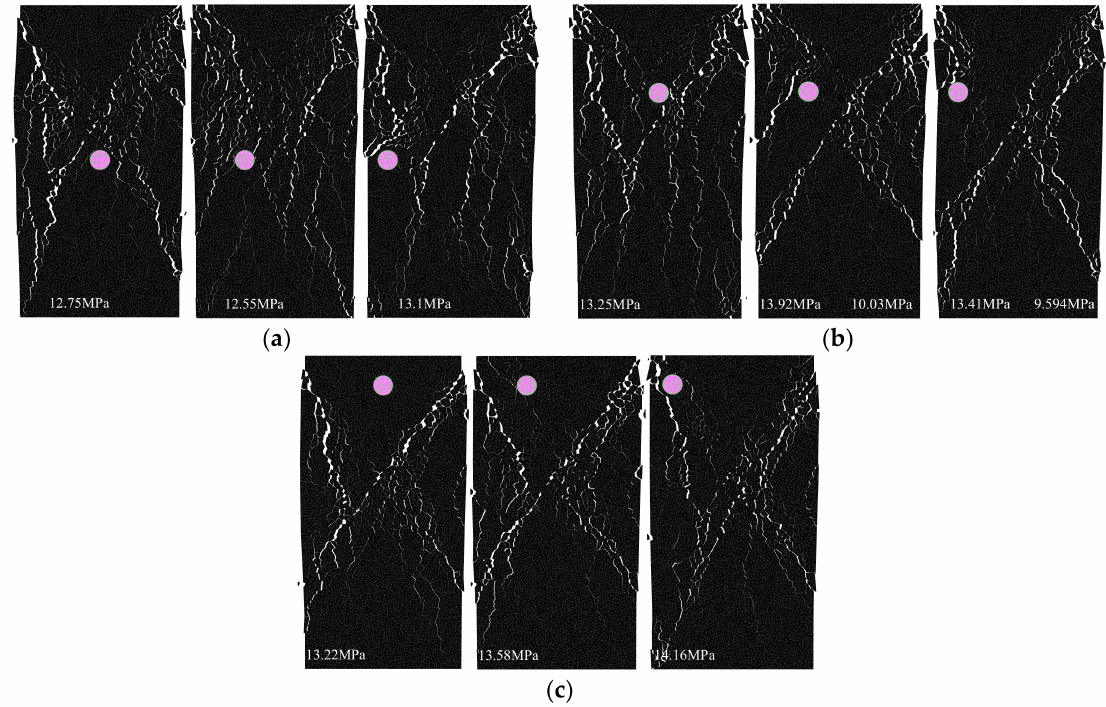
Figure 16. Crack pattern of rock specimen with one mineral circle in different positions after sample is broken: ( a ) level 1: L1–L3; ( b ) level 2: L4–L6; ( c ) level 3: